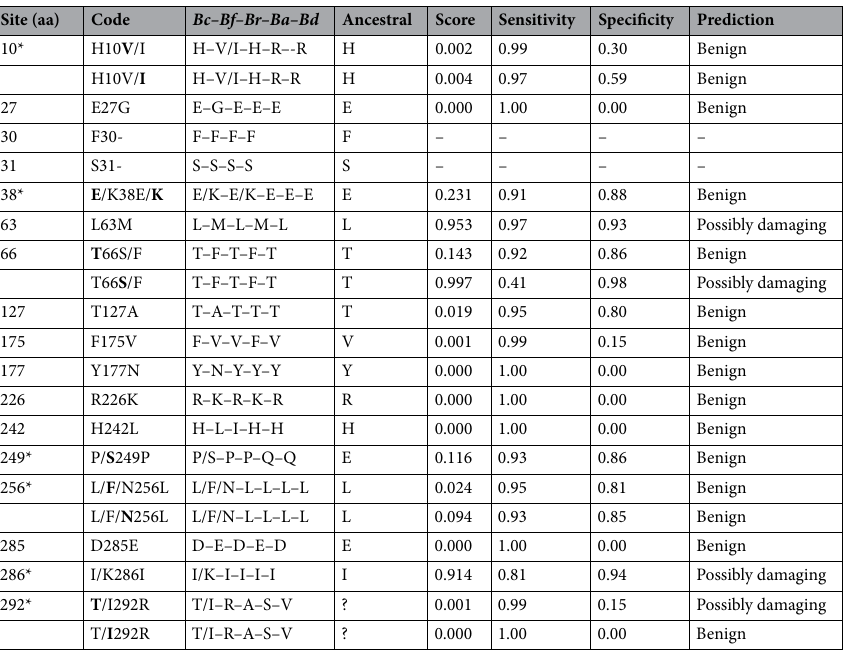
Table 3. Prediction of impact of non-synonymous (fixed or under selection cf. Table 1) amino acid substitutions between B. calyciflorus s.s. and B. fernandoi in comparison to B. rubens , B. angularis and B. diversicornis . Predictions were made using Polyphen2. The code provides details on the amino acid substitution and the position. Bc – Bf – Br – Ba – Bd provides the information of the respective amino acid of B. calyciflorus s.s. ( Bc ), B. fernandoi ( Bf ), B. rubens ( Br ), B. angularis ( Ba ) and B. diversicornis ( Bd ). Ancestral amino acid was inferred using the most parsimonious (i.e., fewest substitutions) scenario, taking the species’ phylogeny into account. In case of multiple amino acids (aa) per species, compared aa are bold in the row Code. Asteriks indicate sites under selection inferred by codeML. Note that Polyphen2 does not consider the possibility of a positive effect of an aa substitution, such that it ranks any predicted change in protein function as